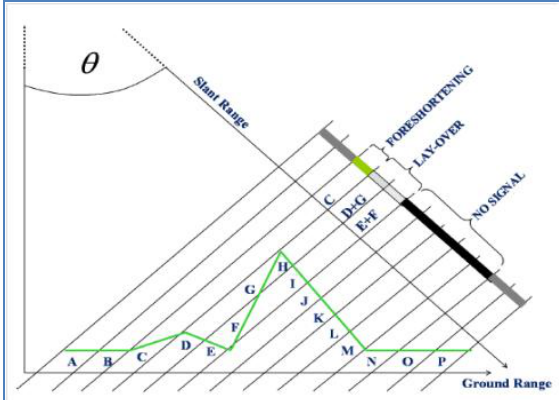
Figure 2. The different geometric distortions in(such as overlay and shadow) explained as the 3D image is projected onto a 2D plane (Ferretti et al.